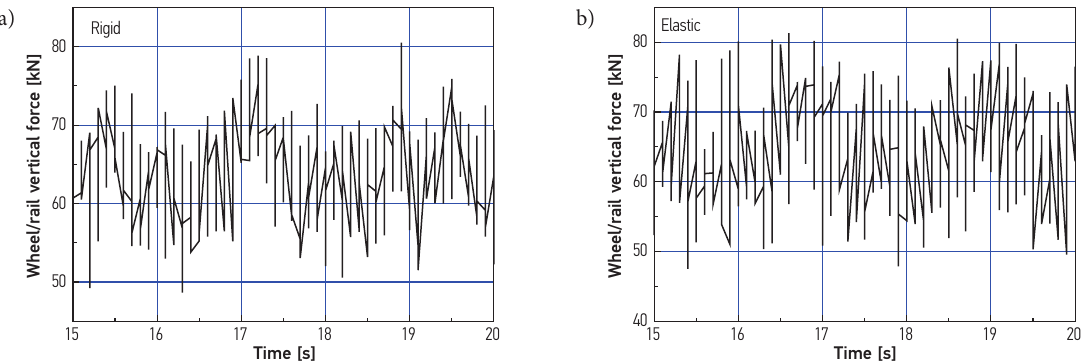
Fig. 12. Time history of wheel / rail vertical force as a function of rigid and elastic model: a – rigid; b –